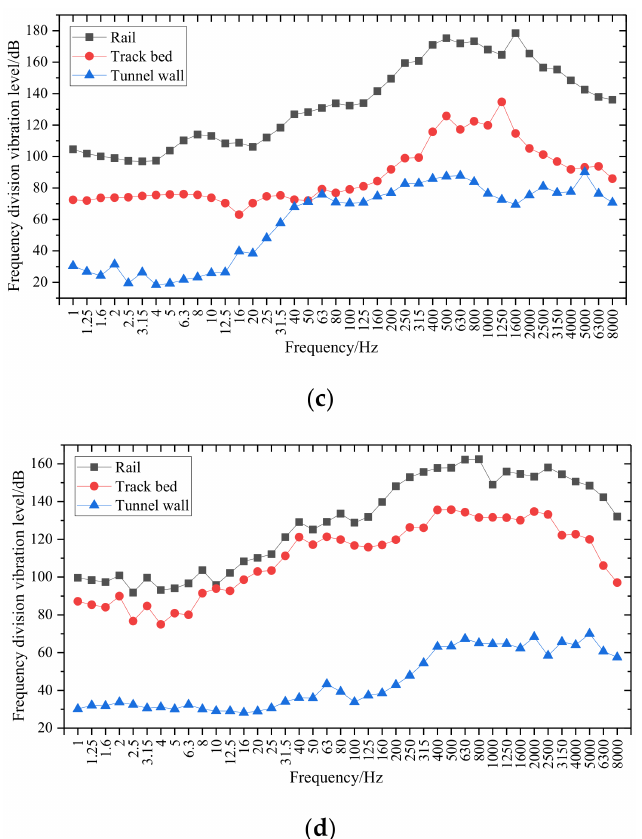
Figure 17. Comparison of frequency-division vibration levels for each condition. ( a ) Straight line segment—ordinary monolithic track; ( b ) straight line segment—steel spring floating slab track; ( c ) curved segment—ordinary monolithic track; ( d ) curved segment—steel spring floating slab